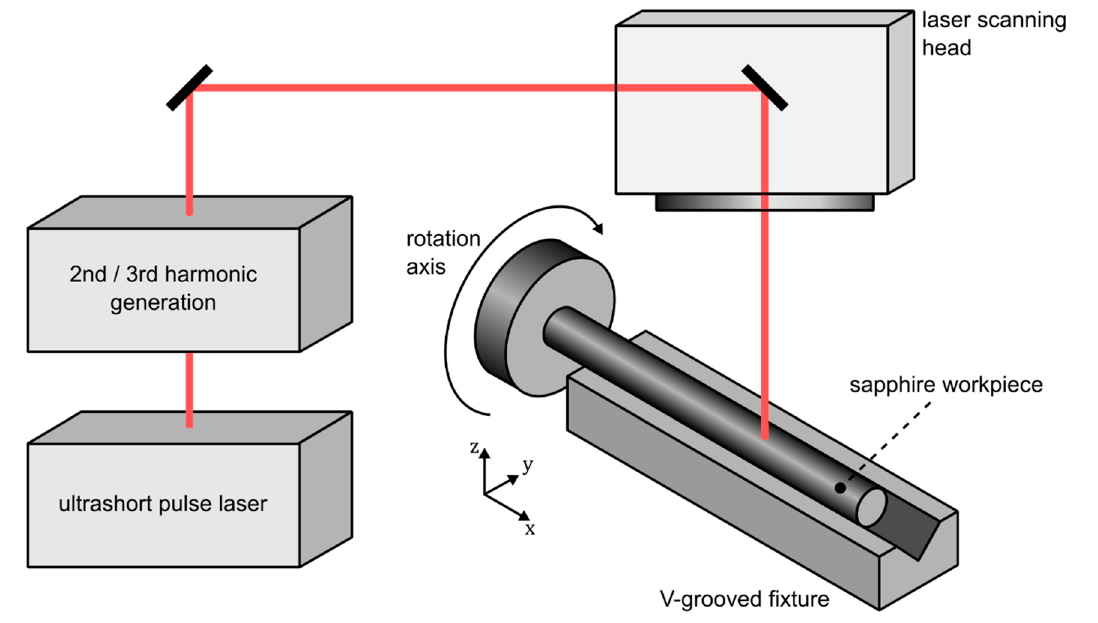
Figure 1. Schematic of the employed laser setup.